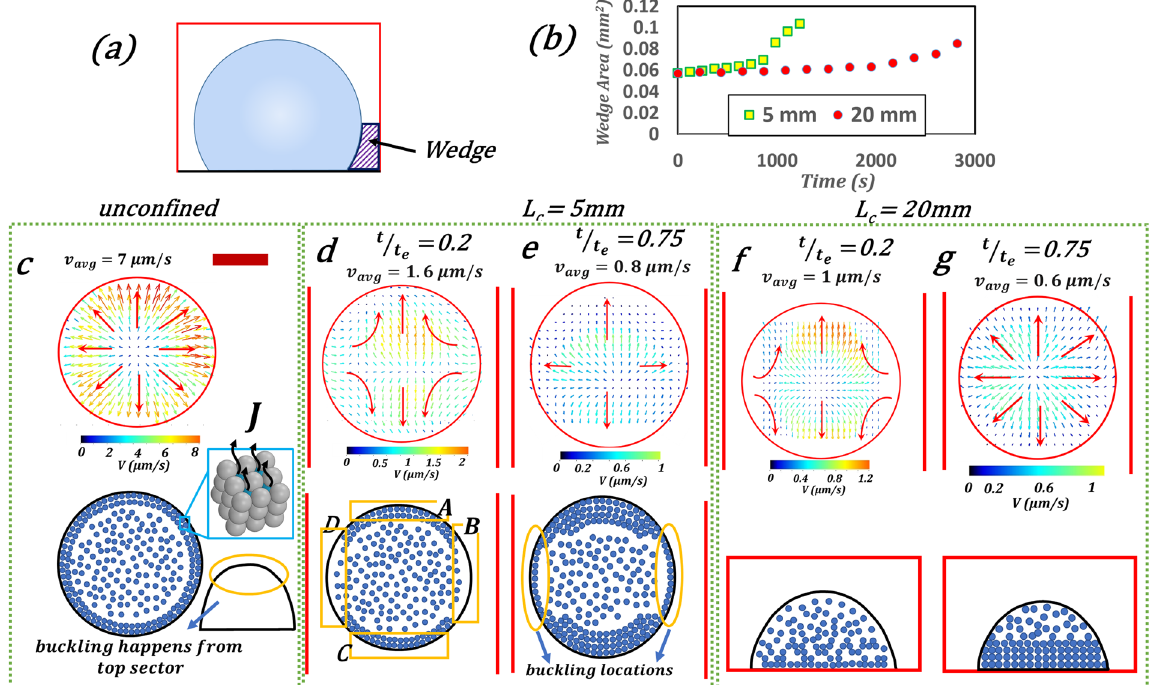
Figure 2. Flow field and particle deposition. ( a ) Representative image of the wedge. ( b ) Temporal variation in wedge area. Internal velocity field of the droplet (measured at = . h h / 0 5 where h i : initial droplet height) and i corresponding schematic showing particle aggregation (second row) for ( c ) unconfined case where the radially outward flow results in azimuthally uniform particle deposition ( d , e ) L c = 5 mm; directional flow leads to thicker shell on the open sides; buckling occurs from the wall (thinner) sides ( f , g ) L c = 20 mm; dome shaped structure is obtained due to low evaporation flux. For all cases, ϕ o = 40 wt .%. Red arrows depict the flow directions. Channel walls are depicted by red lines. Inset in ( c ) shows the evaporation process from nano- menisci. t e : total time for evaporation. Scale bar equals 500 µ m.